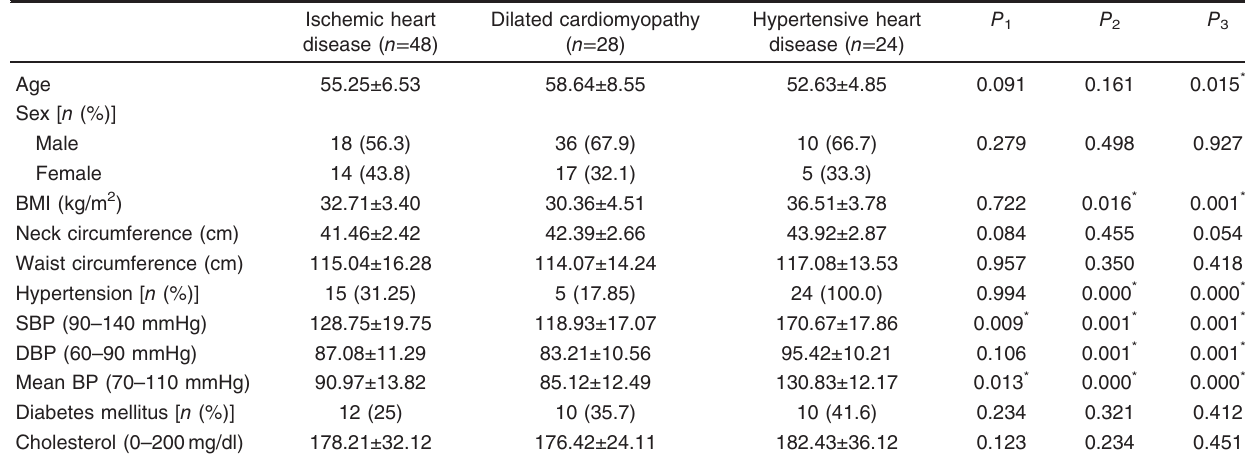
P 1 P 2 P 3 Ischemic heart Dilated cardiomyopathy Hypertensive heart disease ( n = 48) ( n = 28) disease ( n = 24)